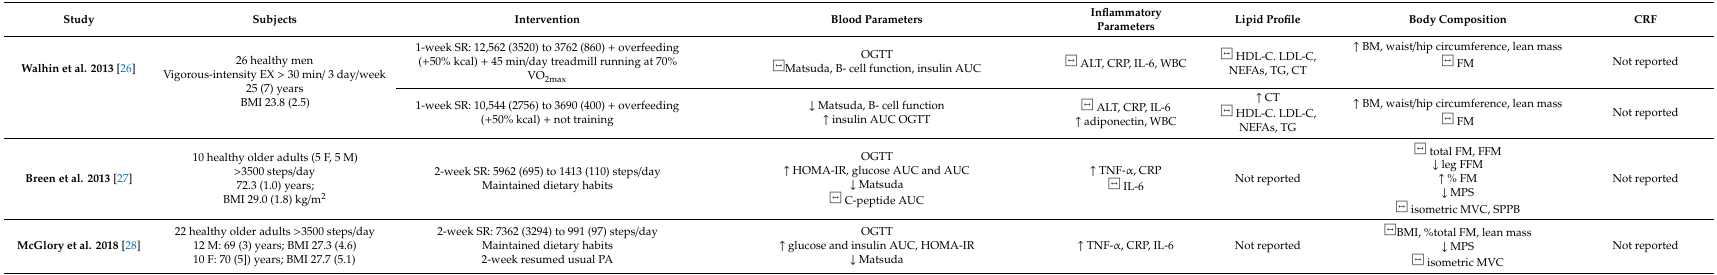
↑ FM. liver fat ↓ total lean mass, lower limb lean mass ↔ arm lean mass FDR+ve: